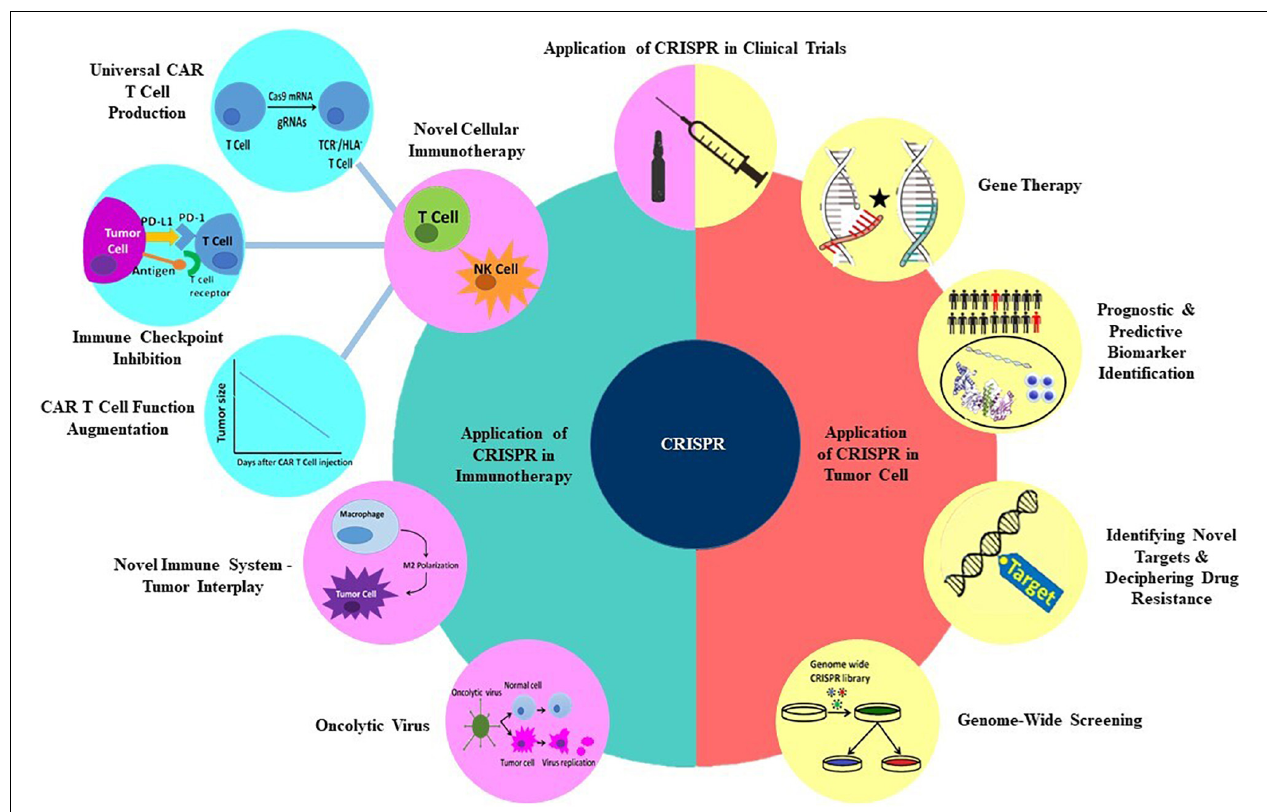
FIGURE 1 | Applications of CRISPR technology in multiple aspects of cancer